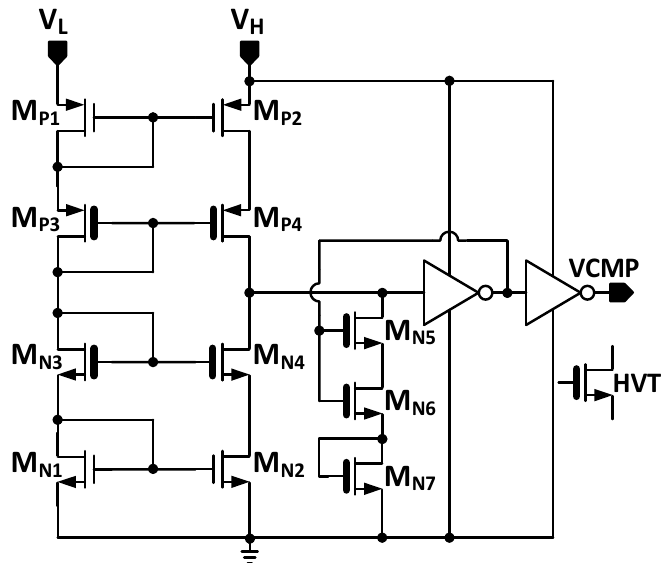
Figure 8. Schematic of the common-gate comparator.